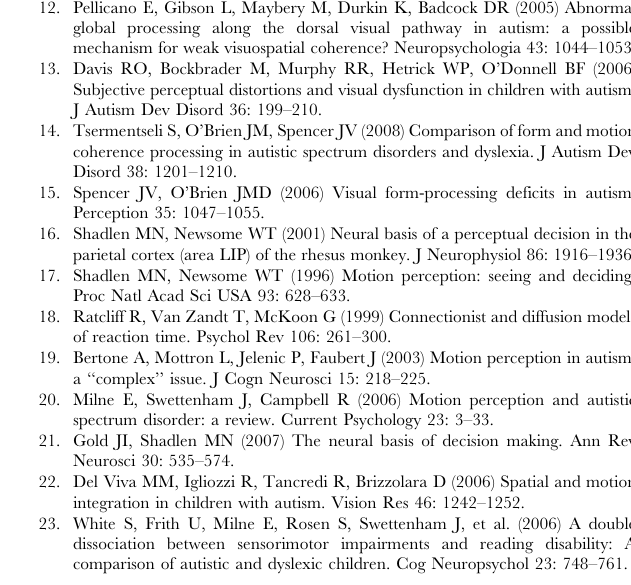
Table S1 Previous psychophysical studies on